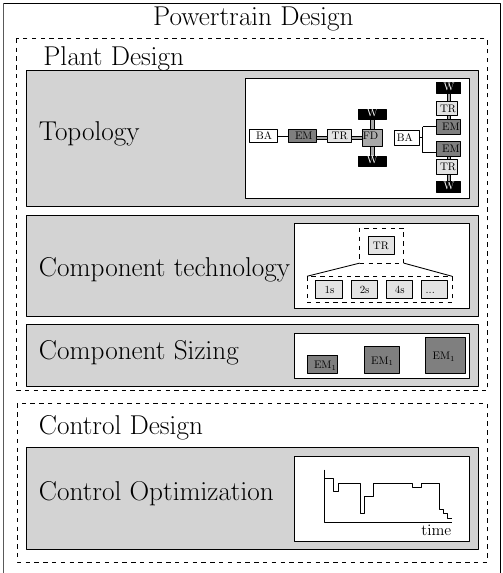
Figure 1. Graphical layout of the powertrain system-level design problem and its main design